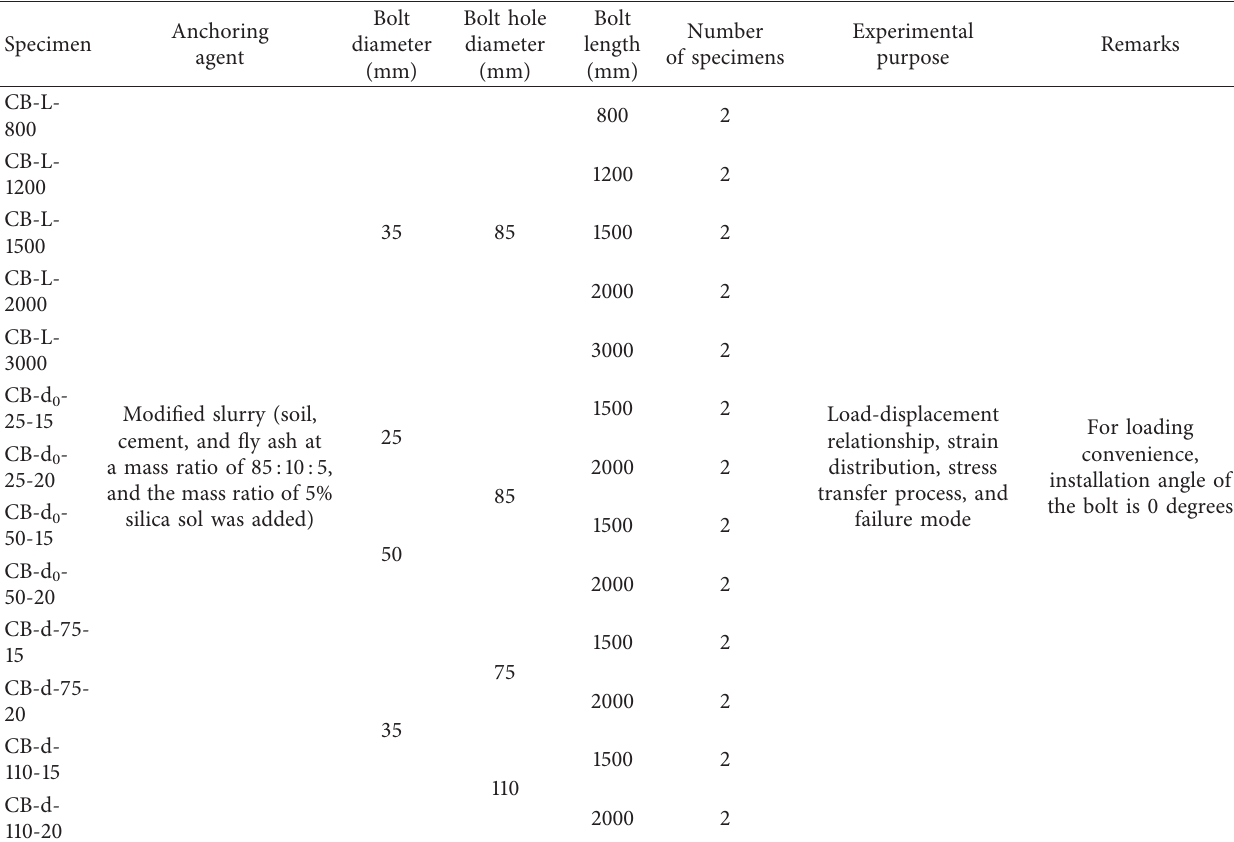
Table 1: Specimen